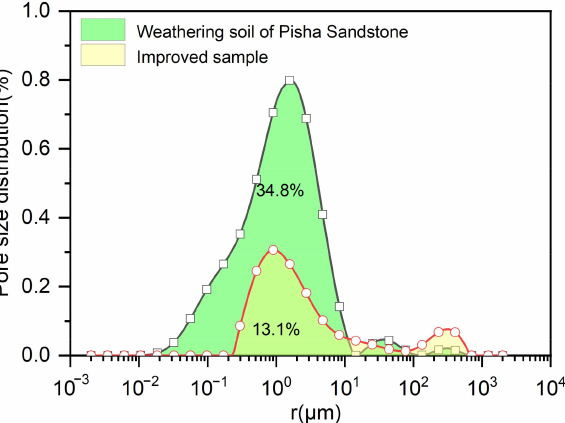
Figure 17. Pore size distribution of Pisha sandstone weathered soil before and after